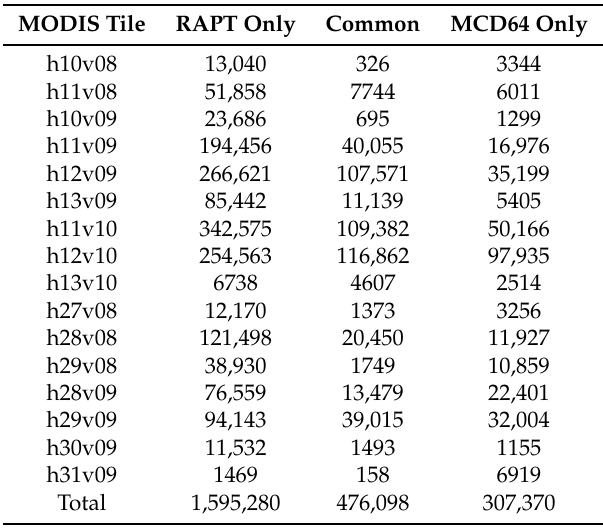
Table 2. Table reports the number of burned pixels (at 500 m. spatial resolution) corresponding to RAPT (only), Common and MCD64 (only) for each tile in the region of study. MODIS Tile RAPT Only Common MCD64 Only h10v08 13,040 326 3344 h11v08 51,858 7744 6011 h10v09 23,686 695 1299 h11v09